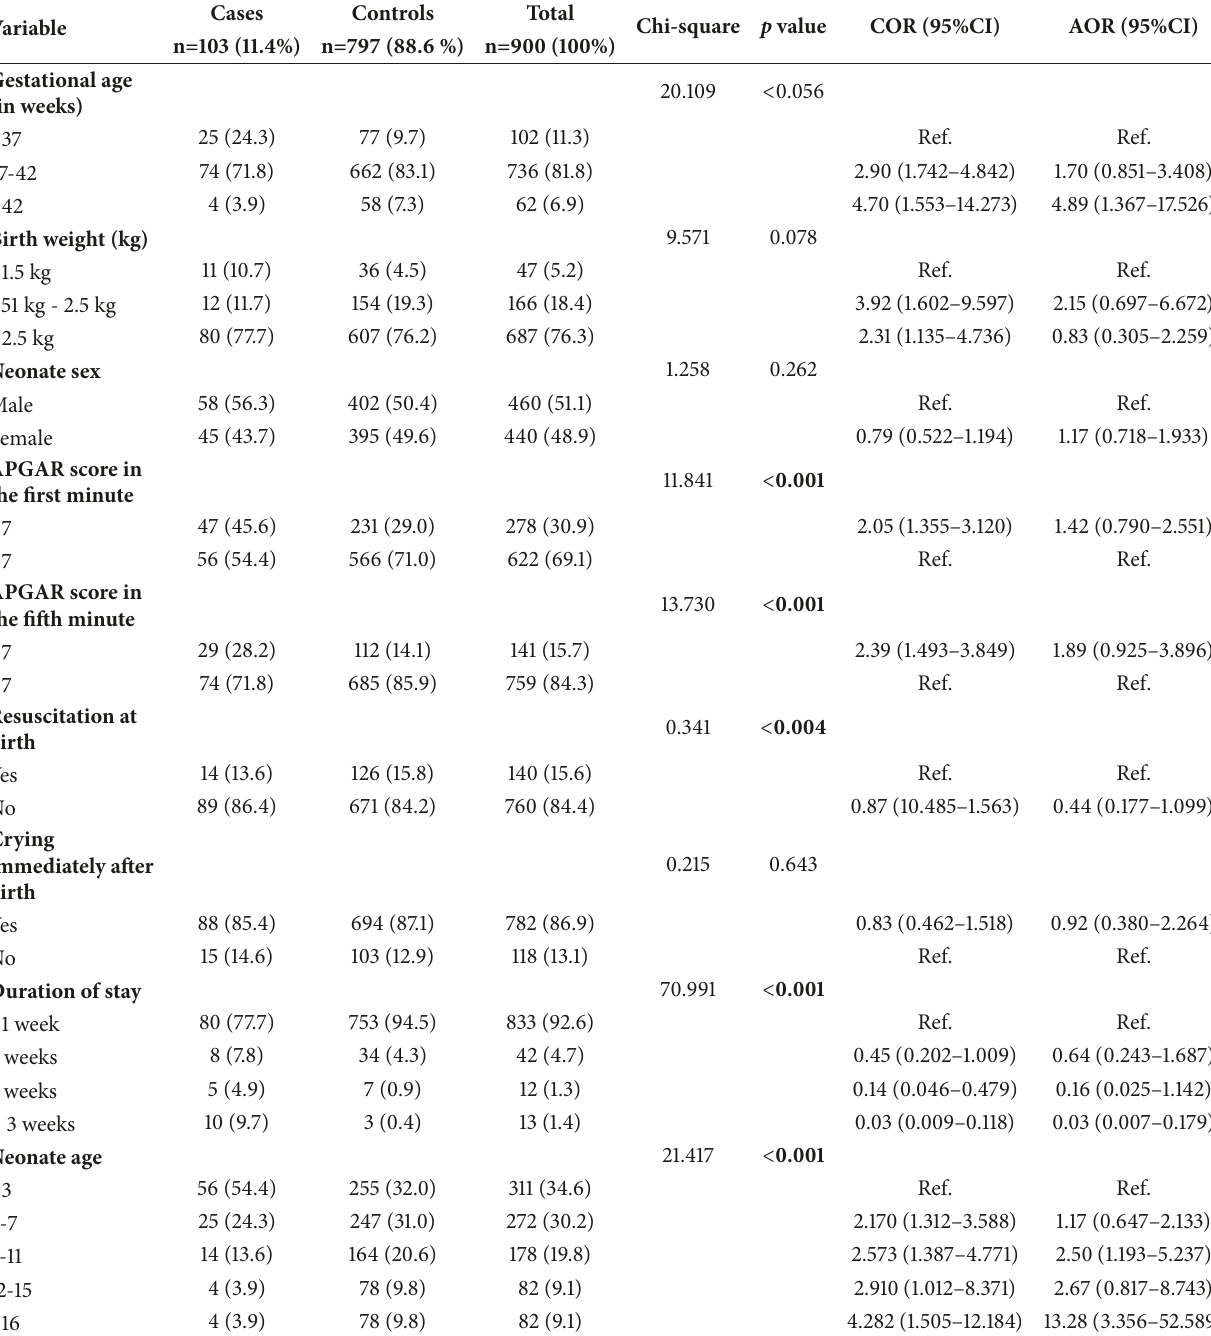
Table 3: Bivariate and multivariate logistic regression analysis on neonatal risk factors of